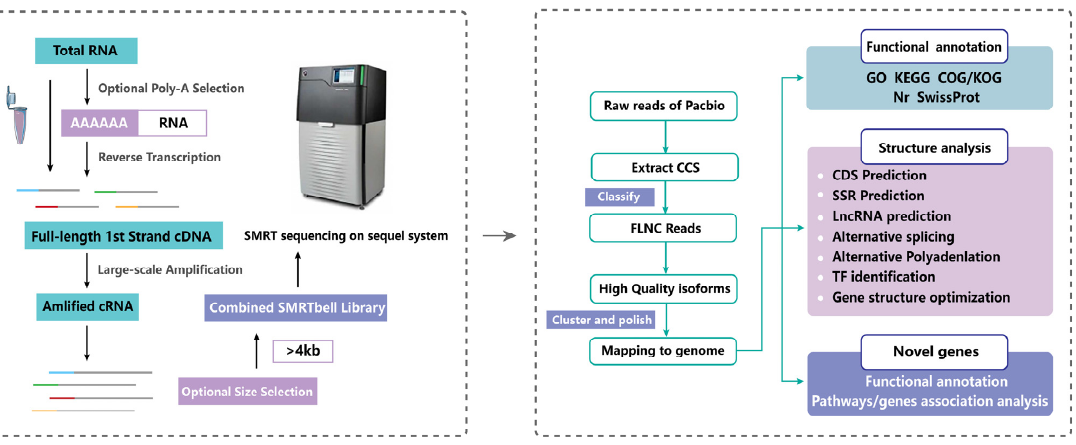
Figure 1. Sequel full length transcriptome cDNA library construction, data processing, and bioinfor- matic analysis. Table 1. The PacBio SMRT sequencing information of H. armiger